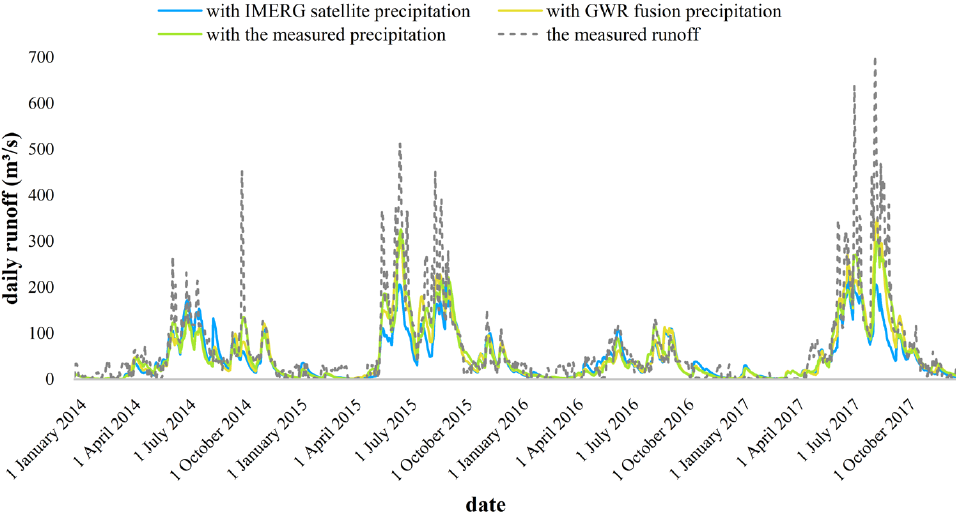
Figure 11. Daily runoff simulation results of multi-source rainfall data. Table 7. Values of evaluation indicators of simulated runoff with different rainfall inputs.